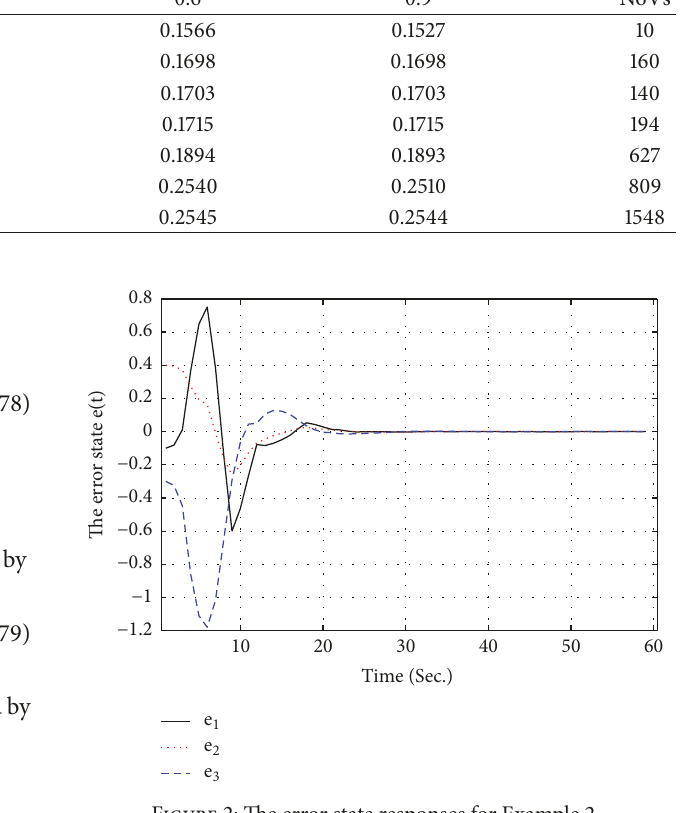
Figure 2: The error state responses for Example